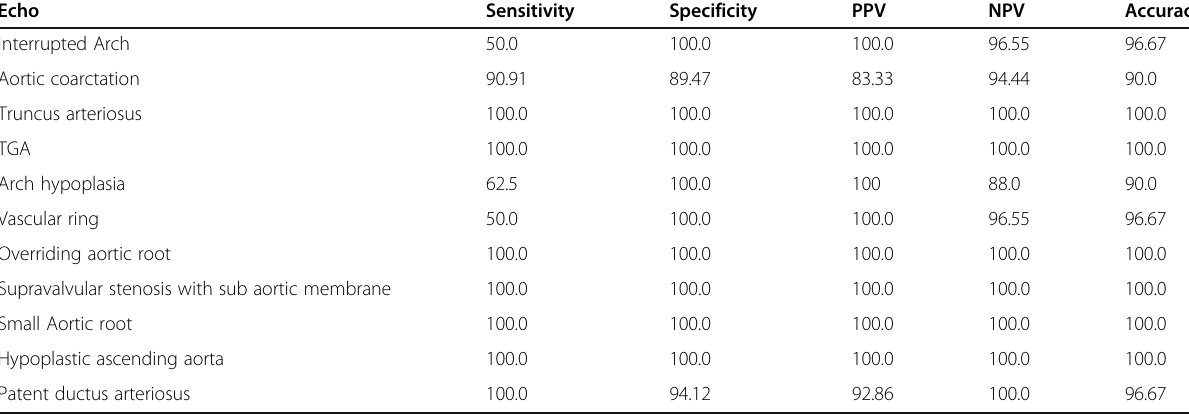
Table 2 Agreement (sensitivity, specificity, and accuracy) for Echo compared to surgery/catheter angiography